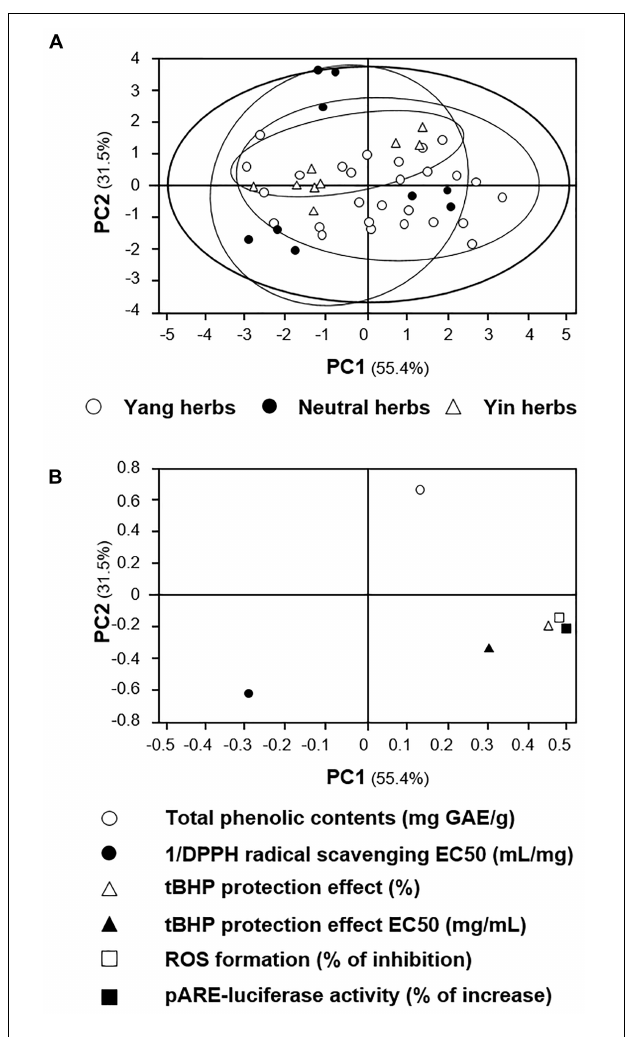
FIGURE 11 | PCA analyses of anti-oxidative profiles of signals from the 15 spleen-meridian herbs. (A) Scoring plots. (B) Loading scatter plots. The distribution of each herbal extract in score scatter plots was calculated according to its correlation with the major components. The classification of the herbal extracts was according to the “Yin-Yang” nature of herbs, i.e., Yin-stimulating, neutral and Yang-stimulating herbs, according to TCM practice. The results showed low discrimination between herbal extracts with anti-oxidative properties. Each dot in the loading scatter plots (B) represents a variable, i.e., the parameters reflecting the anti-oxidant of